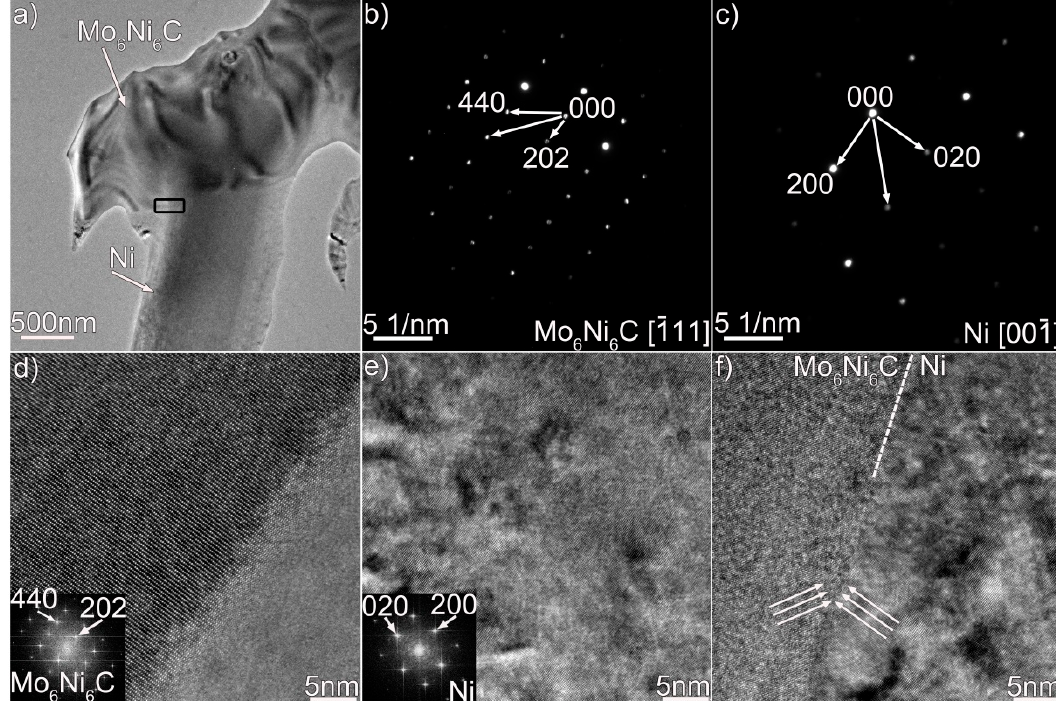
Figure 3. ( a ) Bright-field TEM micrograph of Mo 6 Ni 6 C and Ni in the coating, ( b , c ) SAED patterns of the Mo 6 Ni 6 C and Ni in ( a ), ( d , e ) HRTEM images of the Mo 6 Ni 6 C and Ni in ( a ), and ( f ) HRTEM image of the Mo 6 Ni 6 C/Ni interface enclosed in black box in ( a ).